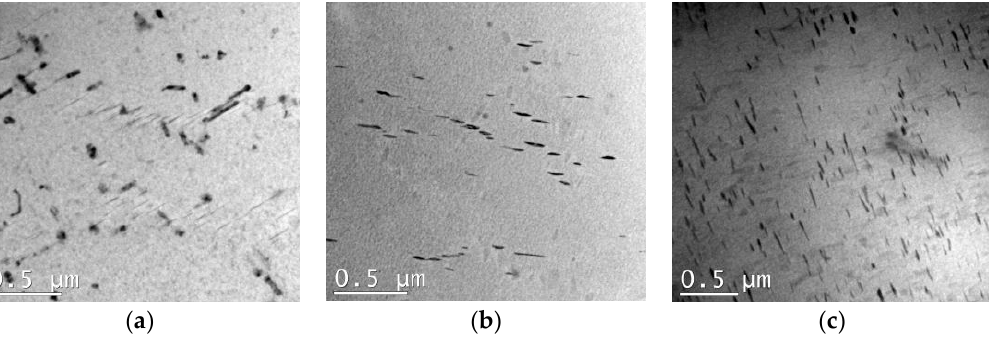
Figure 8. TEM of ZCL205A alloy deposits manufactured with different deposition processes held at 200 °C for 30 min. ( a ) The TEM image of a sample prepared using CMT process; ( b ) the TEM image of a sample prepared using CMT and Pulse process; and ( c ) the TEM image of a sample prepared using the CMT Pulse and Advanced process.